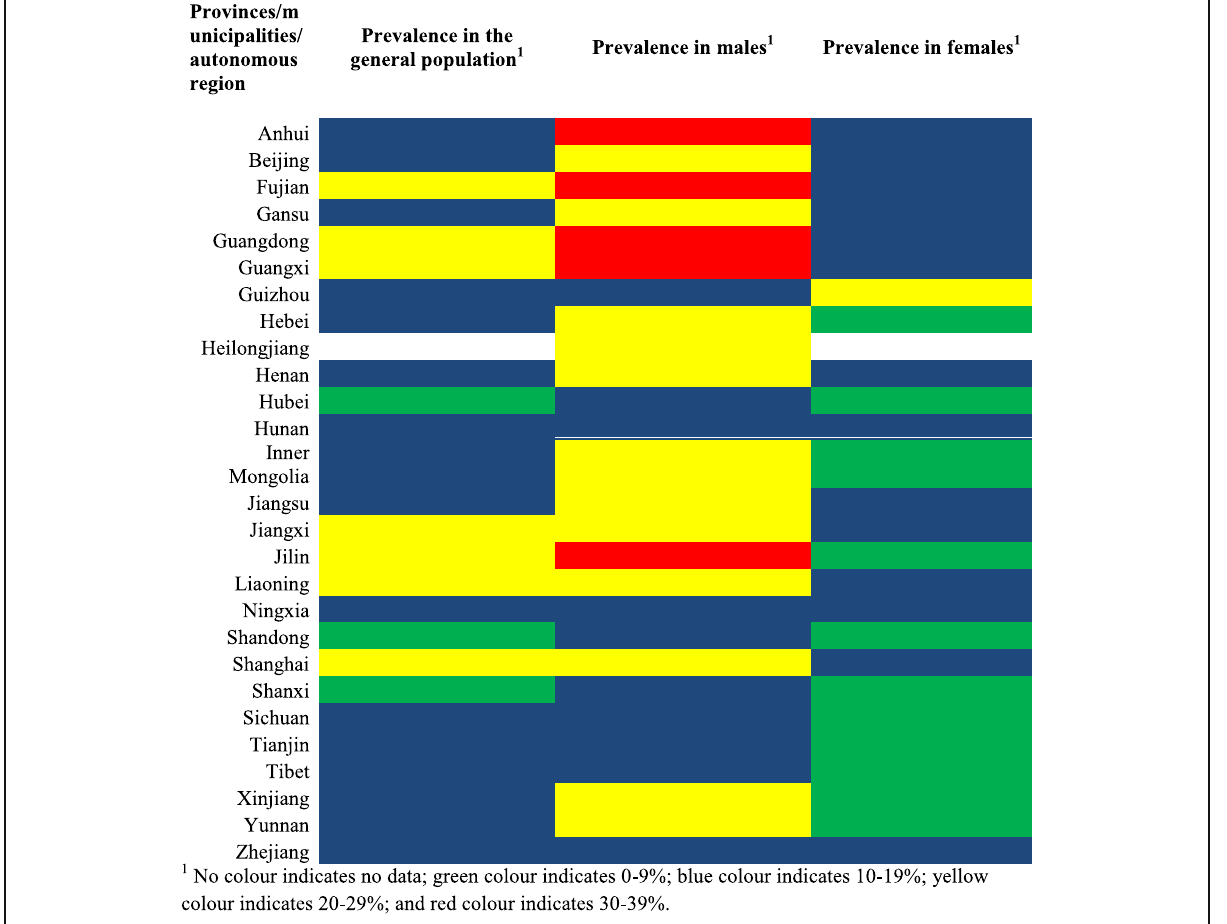
Fig. 3 Prevalence of hyperuricemia in mainland China according to different provinces, municipalities and autonomous